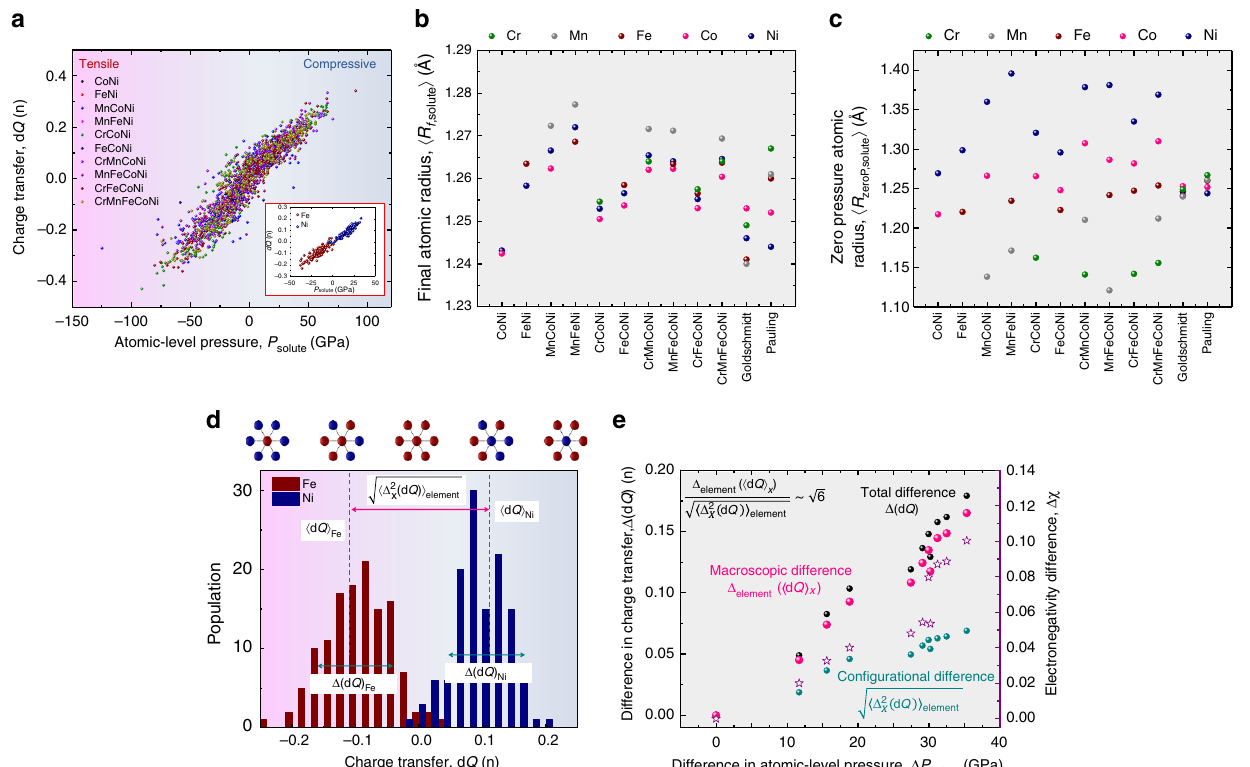
Fig. 3 Relationship among atomic-level pressure difference, charge transfer difference and electronegativity difference in 3d CCAs. a Relationship between the atomic-level pressure and the charge transfer (change in the number of electrons per atom; A positive value means gaining electrons) of 3d CCAs; inset: FeNi. b Average fi nal atomic radii measured by EXAFS and atomic radii of pure elements (Goldschmidt, Pauling). c Average zero pressure atomic radii. d Charge transfer distribution in FeNi. e Relationship among atomic-level pressure difference, charge transfer difference and electronegativity difference in 3d CCAs. Total difference Δ d Q ð Þ (black dot), macroscopic difference Δ